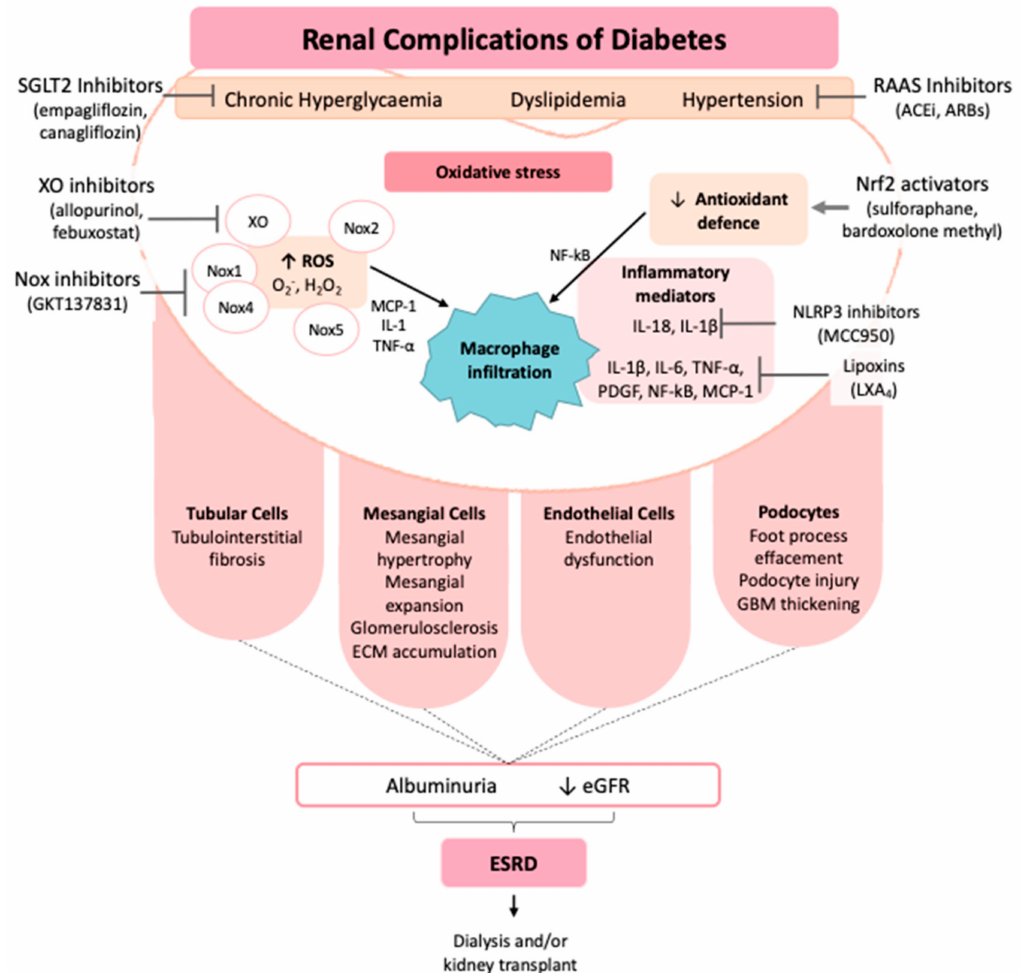
Figure 1. Pathophysiology and therapeutic strategies of diabetic kidney disease. ACEi, angiotensin-converting-enzyme inhibitors; ARBs, angiotensin receptor blockers; eGFR, estimated glomerular filtration rate; ESRD, end-stage renal disease; H 2 O 2 , hydrogen peroxide; IL, interleukin; MCP-1, monocyte chemotactic protein-1; NF- κ B, nuclear factor- κ B; NLRP3, NLR family pyrin domain containing 3; Nox, NADPH oxidase; Nrf2, nuclear factor erythroid 2–related factor 2; O - 2 , superoxide; PDGF, platelet-derived growth factor; RAAS, renin–angiotensin–aldosterone system; ROS, reactive oxygen species; SGLT2, sodium–glucose co-transporter 2; TNF- α , tumor necrosis factor alpha; XO, xanthine